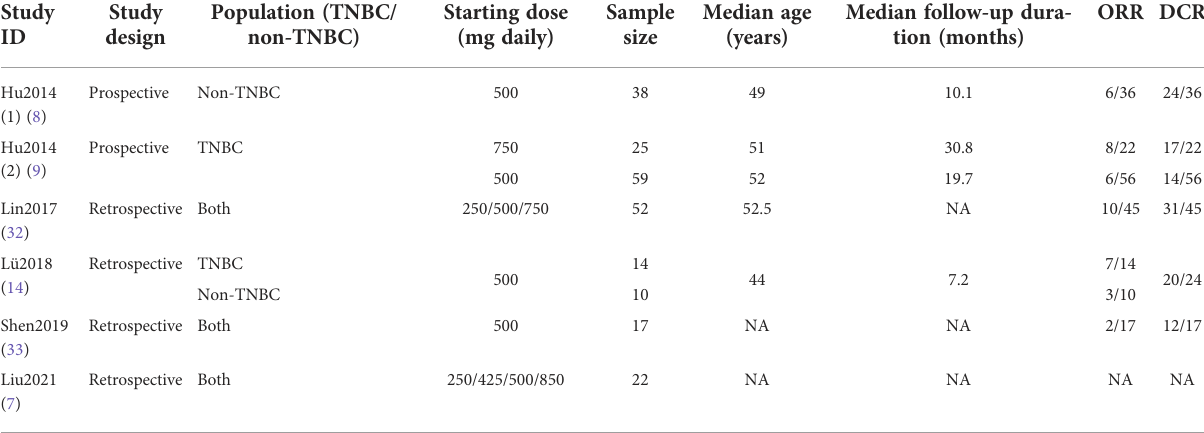
TABLE 2 Outcomes of interest extracted from the included studies.